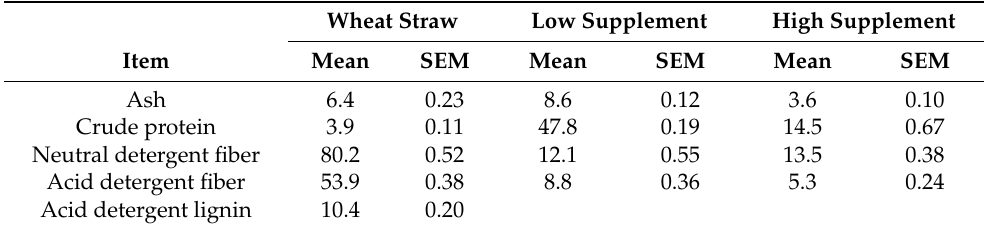
Table 1. Composition of wheat straw and supplements (%, dry matter basis) 1 .